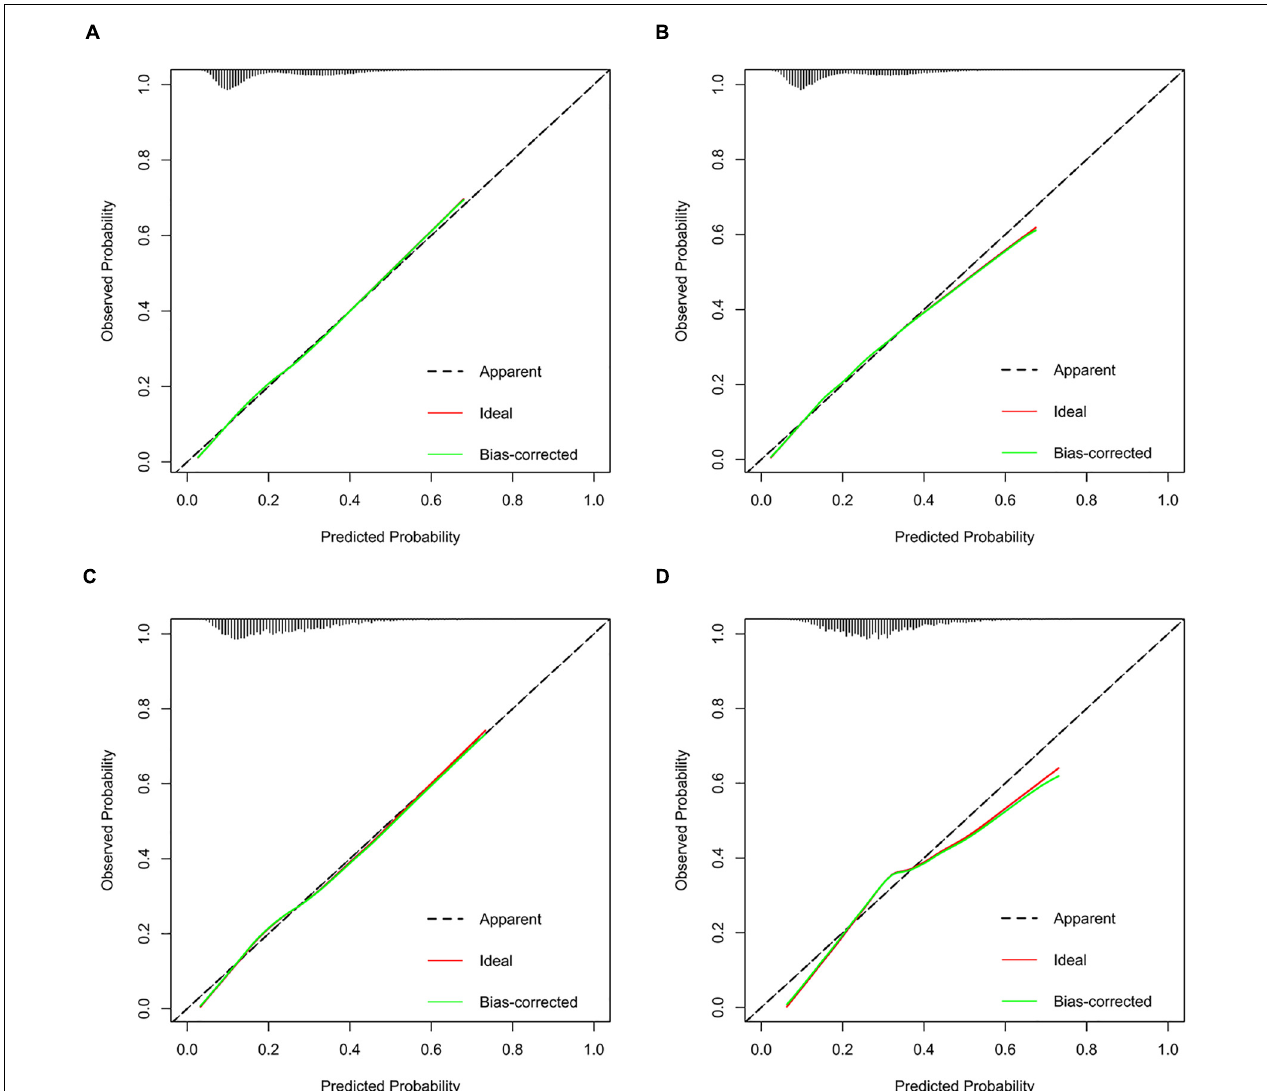
FIGURE 4 | Calibration curves of the HF incidence risk nomogram prediction in training set (A) , internal validation set (B) , external validation set1 (C) , and external validation set2 (D)